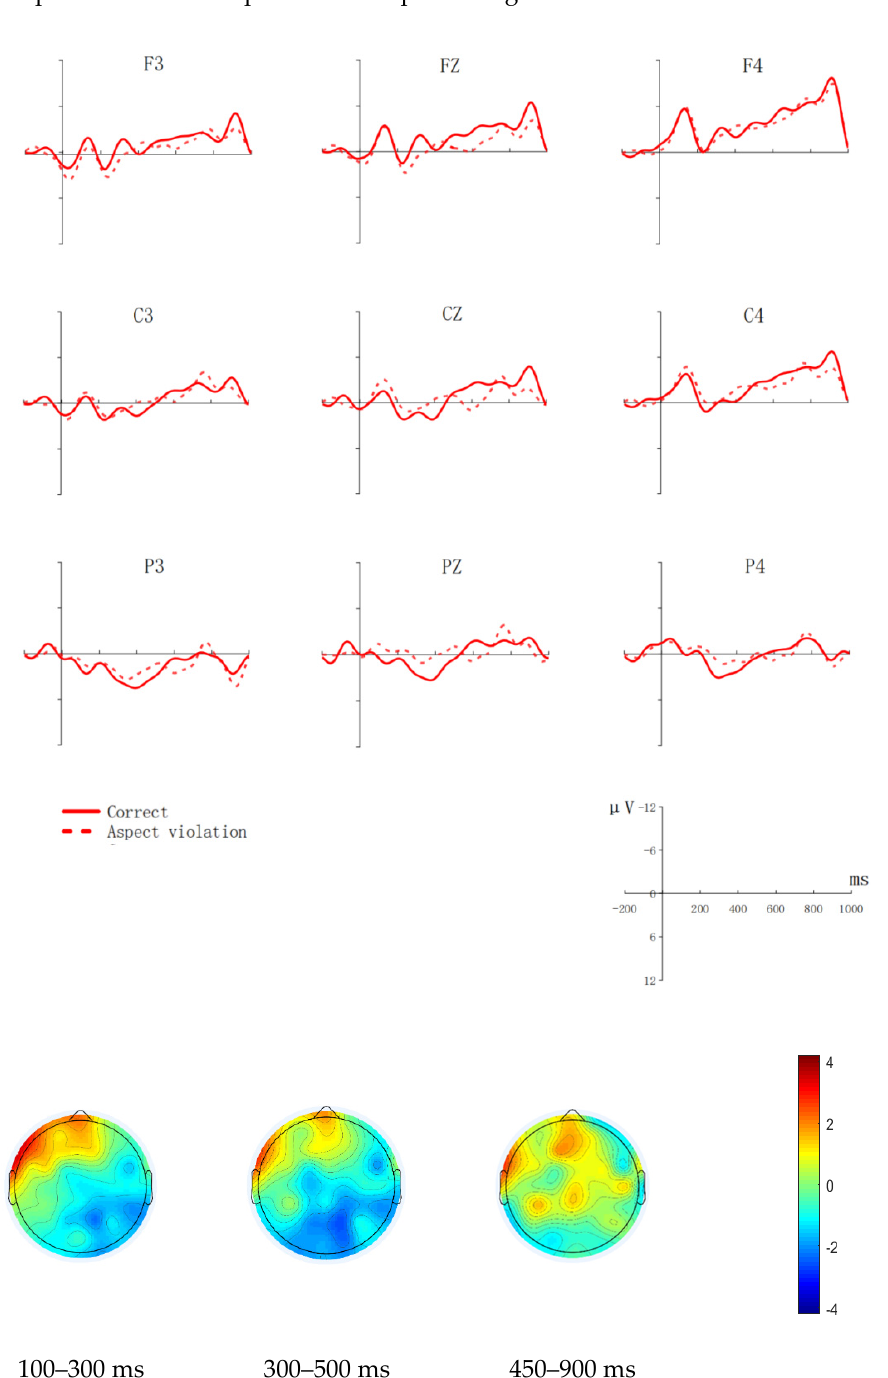
Figure 3. Grand average (N = 20, with 20 valid samples) ERPs of the Thailand group at 9 exemplar electrodes time-locked to the onset (0 ms) of the aspect marker “ le ” as a function of aspect agreement. The x -axis represents the duration, and each hash mark represents 200 ms. The y -axis represents the voltage, which ranged from − 12 to +12 µ V. Negativity is plotted upward. The topographical voltage map represents the difference waves effects (the aspect violation condition minus the correct condition) at 100–300 ms, 300–500 ms, and 450–900 ms, respectively.